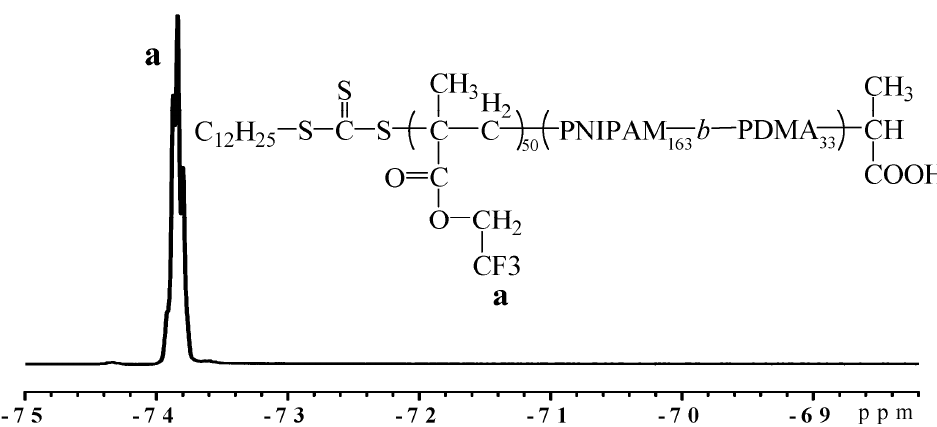
Figure 4. 19 F-NMR spectrum of P(DMA 33 - b -NIPAM 163 - b -TFEMA 50 )-S-(C=S)-S-C 12 H 25 nanoparticles.